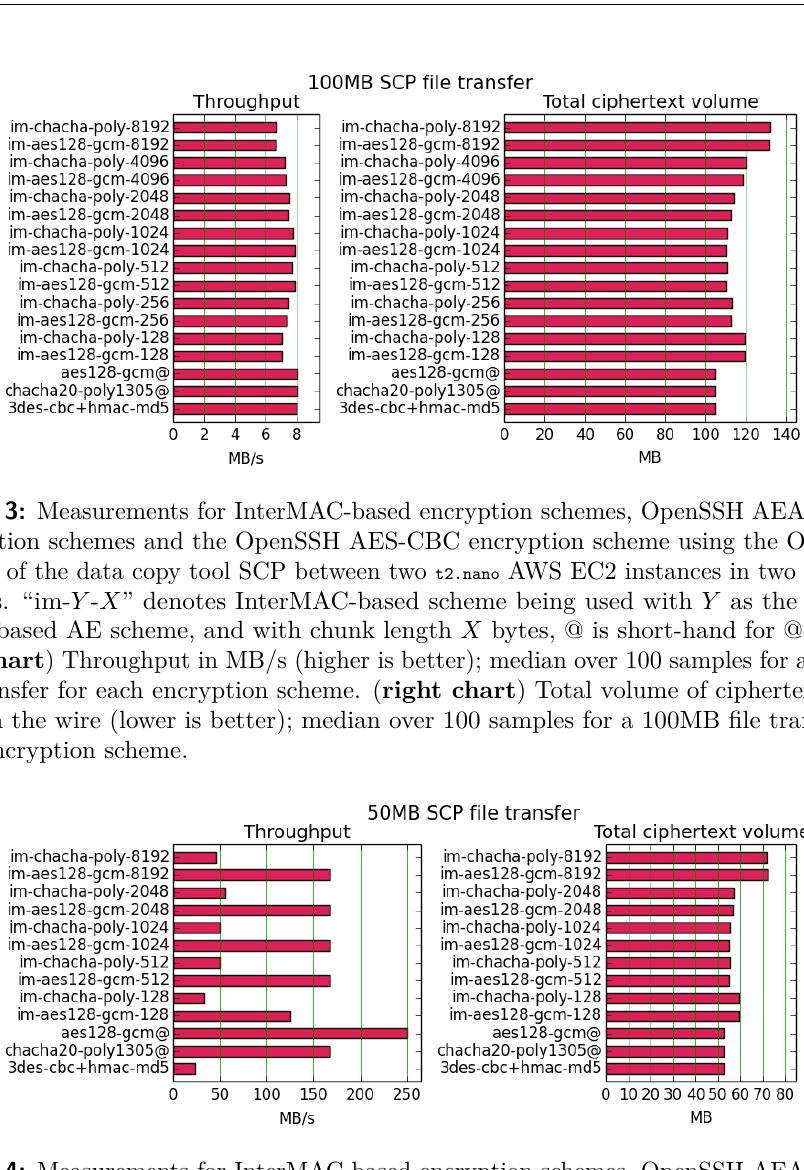
Figure 4: Measurements for InterMAC-based encryption schemes, OpenSSH AEAD-based encryption schemes and the OpenSSH AES-CBC encryption scheme using the OpenSSH version of the data copy tool SCP between two dedicated m4.large AWS EC2 instances in two different availability zones. “im- Y - X ” denotes InterMAC-based scheme being used with Y as the internal nonce-based AE scheme, and with chunk length X bytes, @ is short-hand for @openssh. ( left chart ) Throughput in MB/s (higher is better); median over 100 samples for a 50MB file transfer for each encryption scheme. ( right chart ) Total volume of ciphertext bytes sent on the wire (lower is better); median over 100 samples for a 50MB file transfer for each encryption